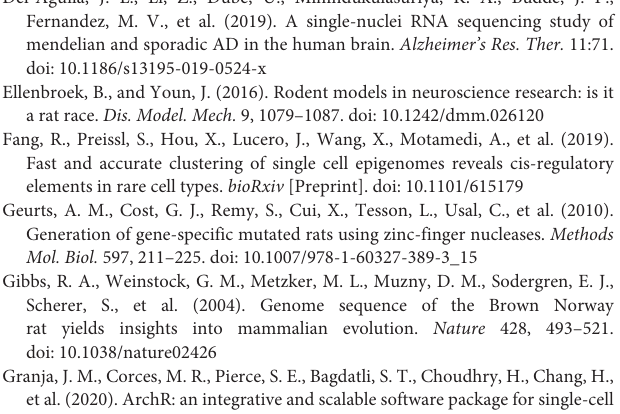
SUPPLEMENTARY TABLE 3 | Differential gene activity scores in each cell type. SUPPLEMENTARY TABLE 4 | TF motif enrichment in each cell